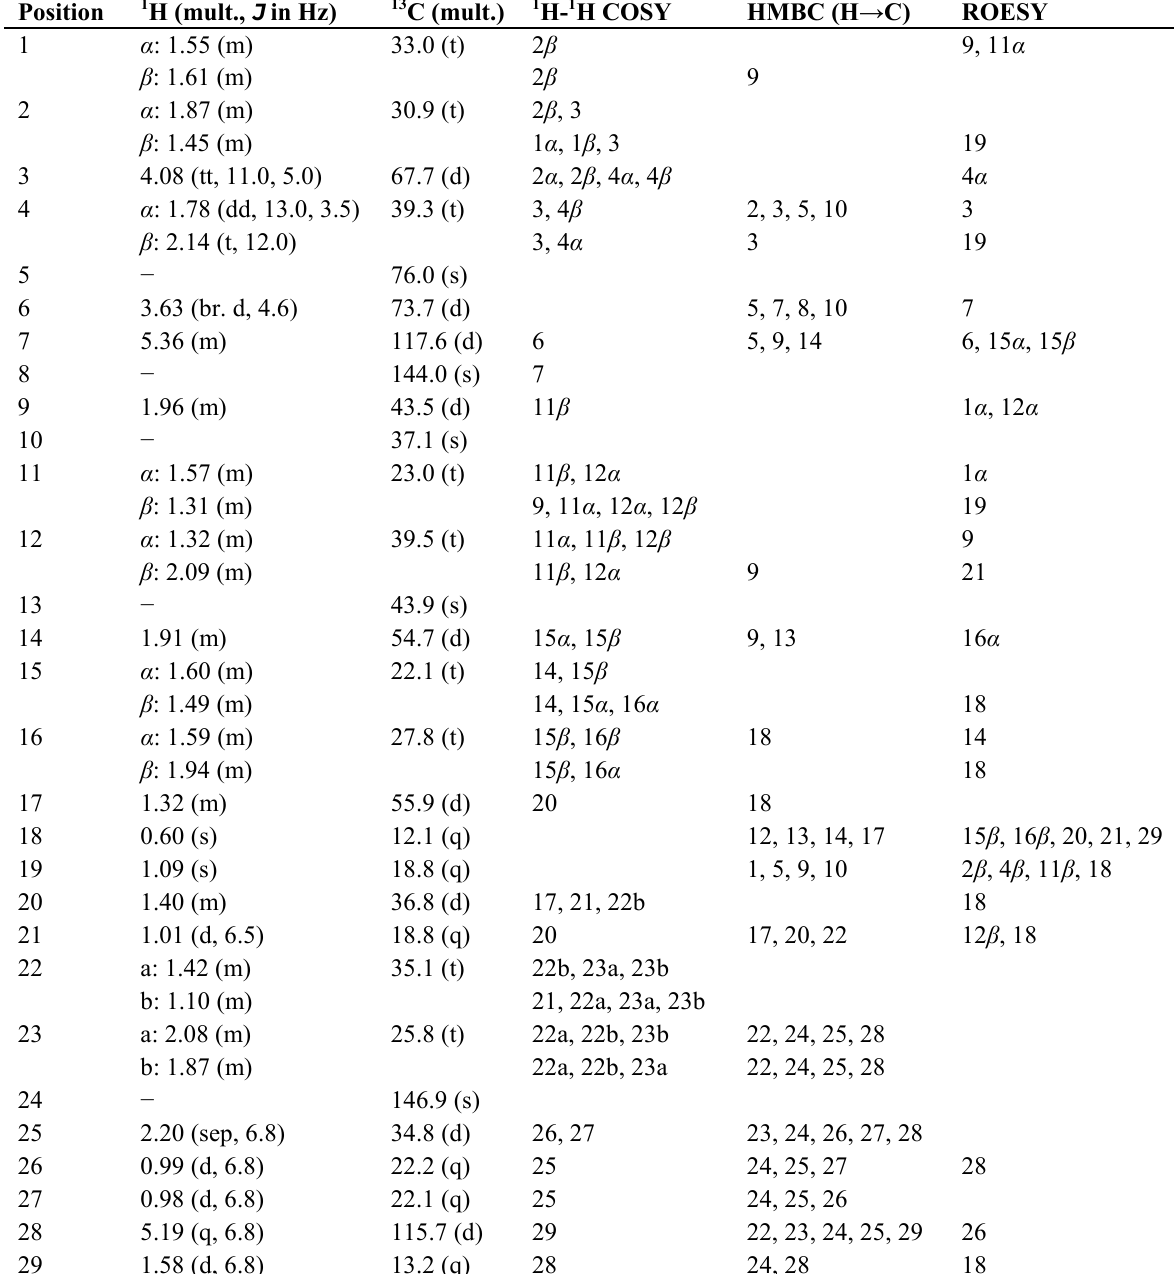
Table 3. 1 H- (600 MHz) and 13 C-NMR (150 MH) data for 3 in CD